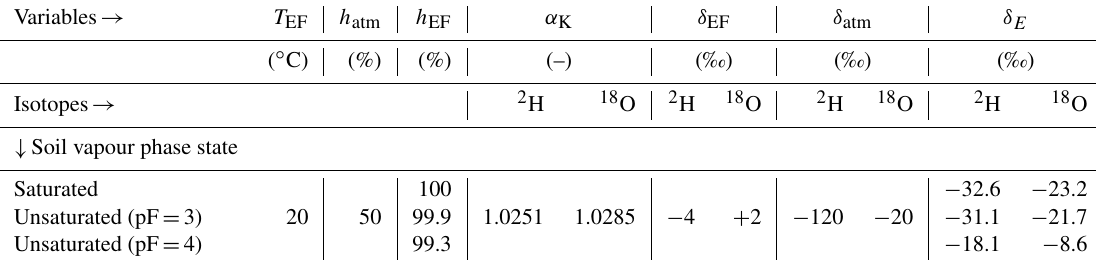
Table 1. Effect of the consideration of non-saturated soil water vapour phase on the estimation of the isotopic composition of evaporation ( δ E ) using the model of Craig and Gordon (1965). Conditions of the transport of pure diffusive water vapour ( n = 1) prevail, leading to values of the kinetic fractionation factor ( α K ) of 1.0251 und 1.0285 for 2 H and 18 O. Values for T EF , h atm , δ EF , and δ atm are chosen exemplarily. Variables → T EF h atm h EF α K